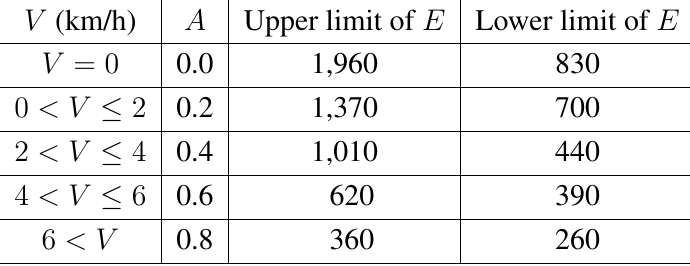
Table 2 . Mapping from V to A and range of E